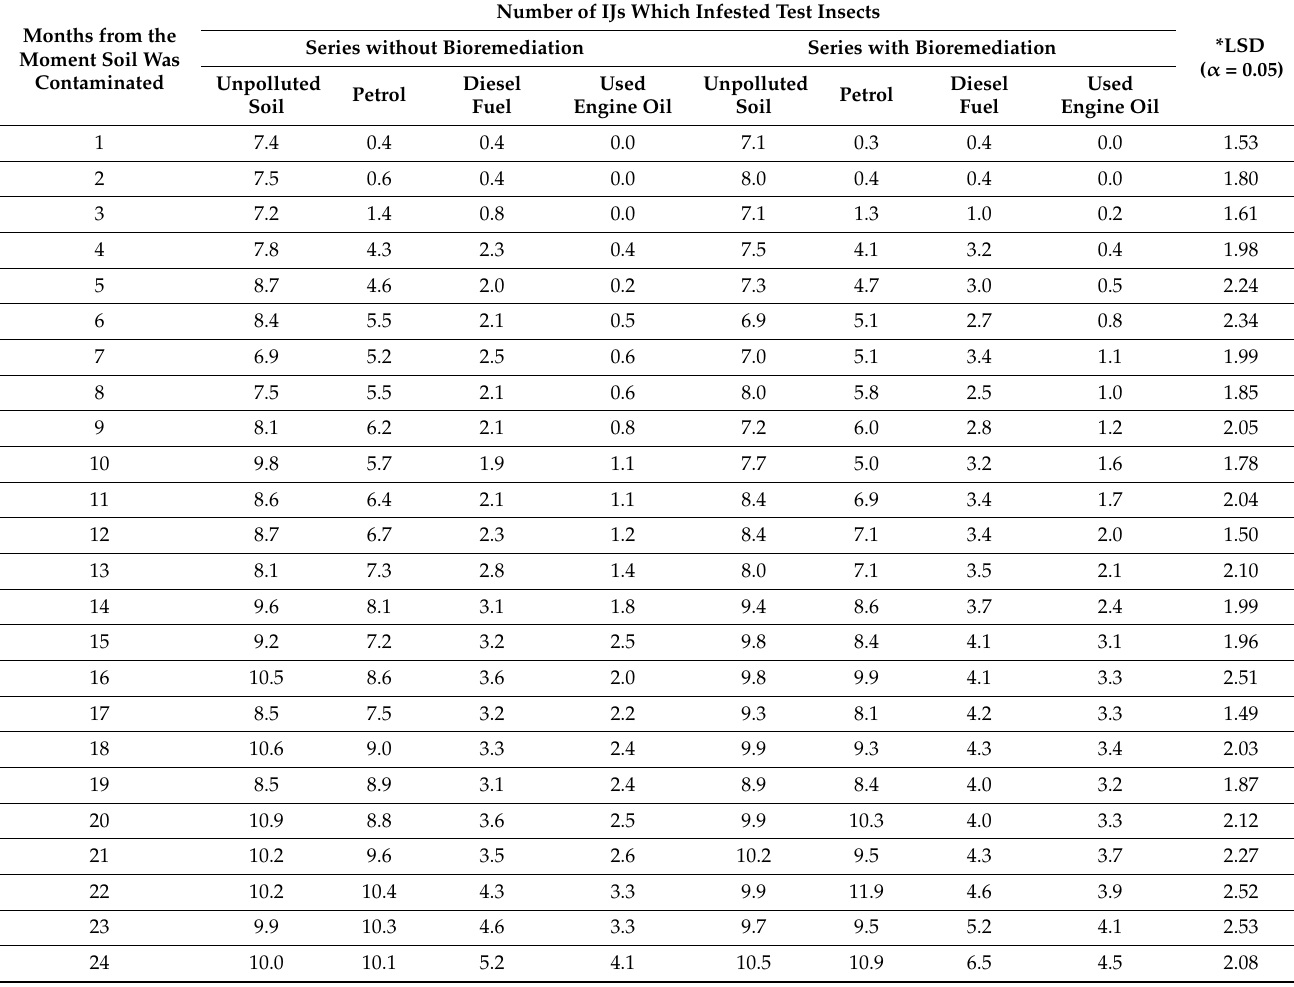
Table 2. The effect of oil derivatives on the intensity of penetration of test insects ( T. molitor ) by S. feltiae